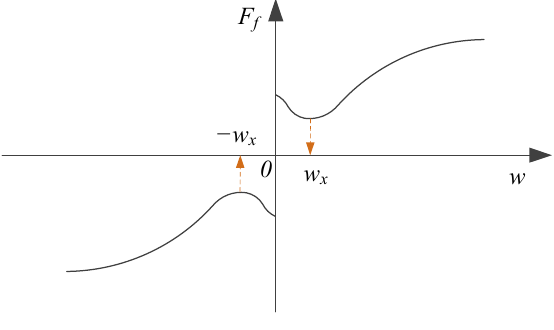
Figure 12. Stribeck friction curve.